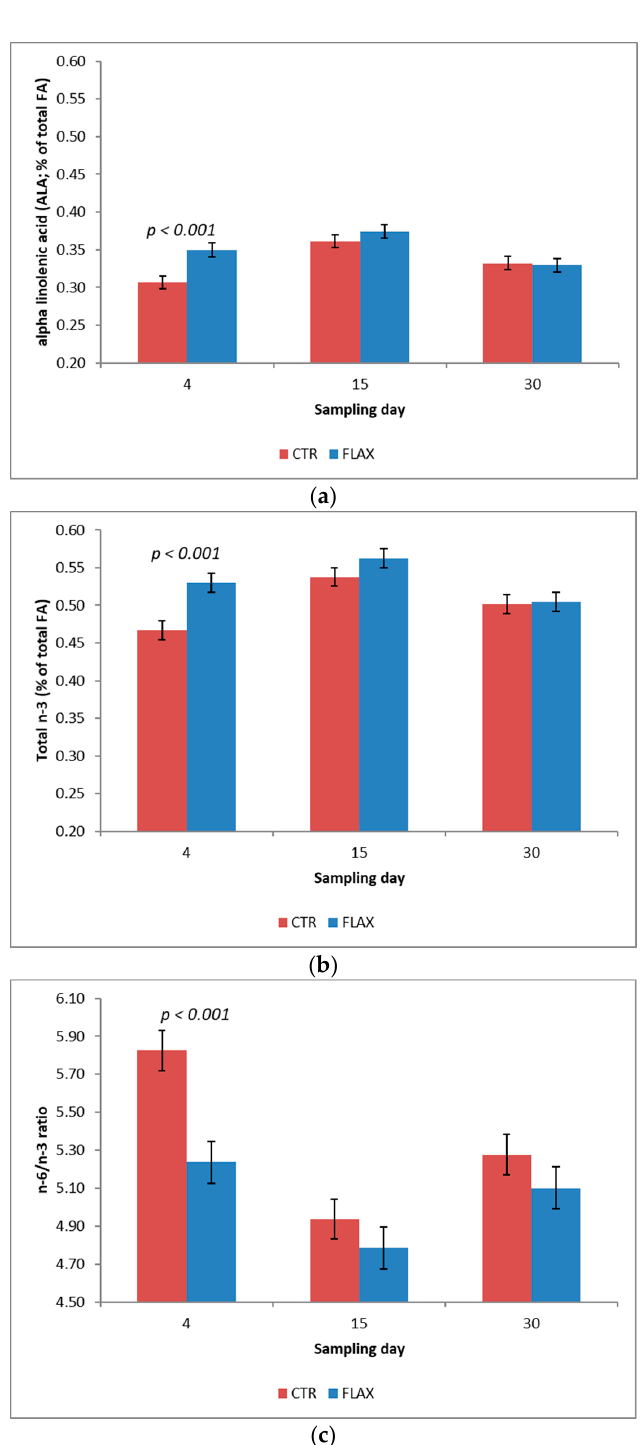
Figure 2. Least square means for control (CTR; dark red bars) and flaxseed supplemented diets (FLAX; blue bars): ( a ) alpha linolenic acid (ALA); ( b ) total n-3 fatty acids contents (expressed as % on the total fatty acids); and ( c ) n-6: n-3 ratio in the early and commercial milk. Differences between treatments within sampling day have been reported when significant ( p < 0.05 or less).